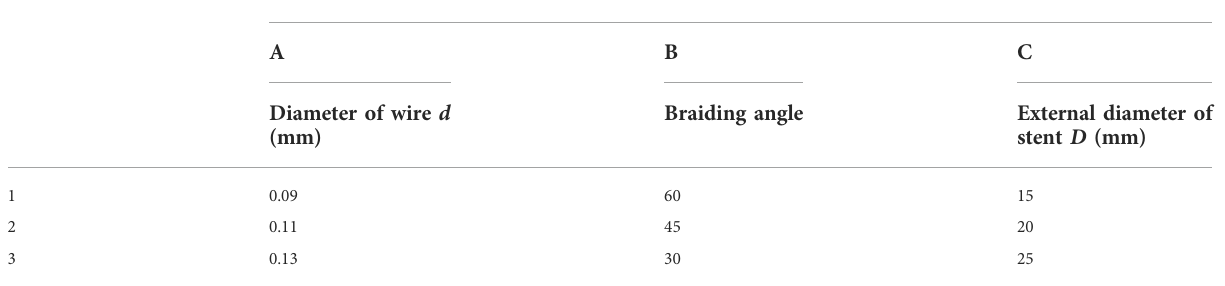
TABLE 2 Factors and levels of the orthogonal test of the nasal stent.